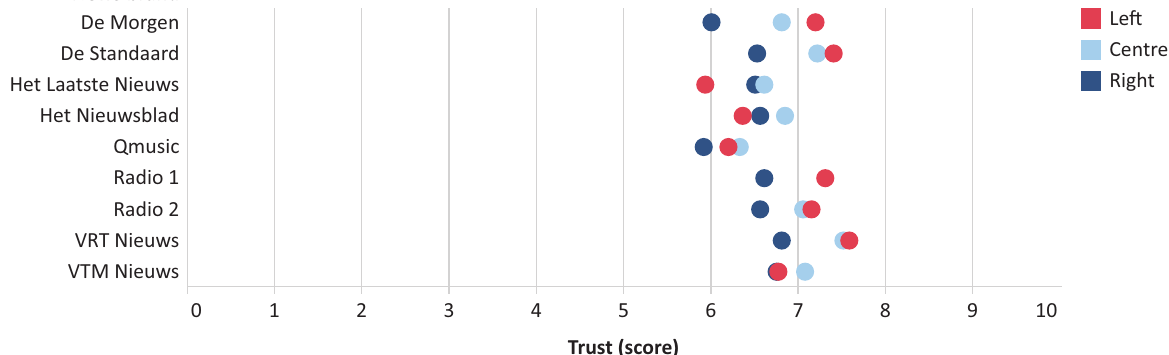
Figure 3. Trust in news brands by political orientation. Notes: The question was ‘How trustworthy would you say news from the following brands is? Please use the scale below, where 0 is “not at all trustworthy” and 10 is “completely trustworthy.”’ See Table 3 in Supplementary File Annex 2 for exact numbers and statistical significance